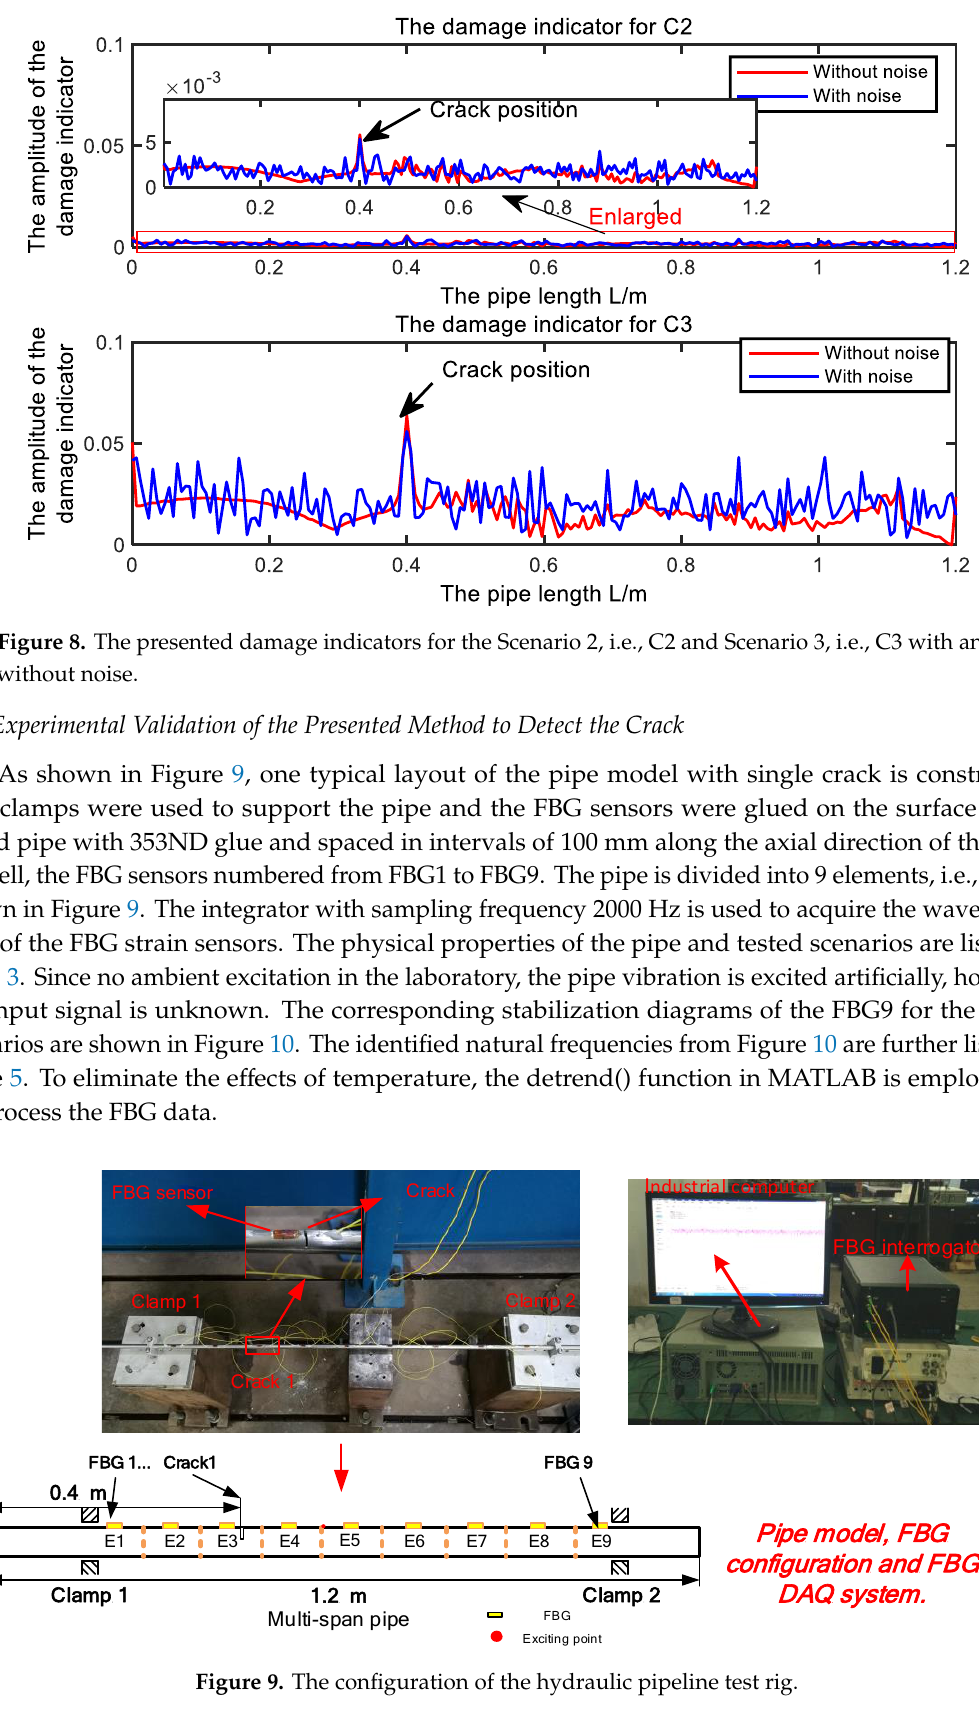
Figure 10. The stabilization diagram of the FBG 9. (black asterisk- frequency variation ratio [0 – 0.5%], Pink dot-frequency variation ratio [0. 5% – 1%]): ( a ) The health; ( b ) the C2; ( c ) the C3. Table 5. The identified first four natural frequencies. Scenario. No